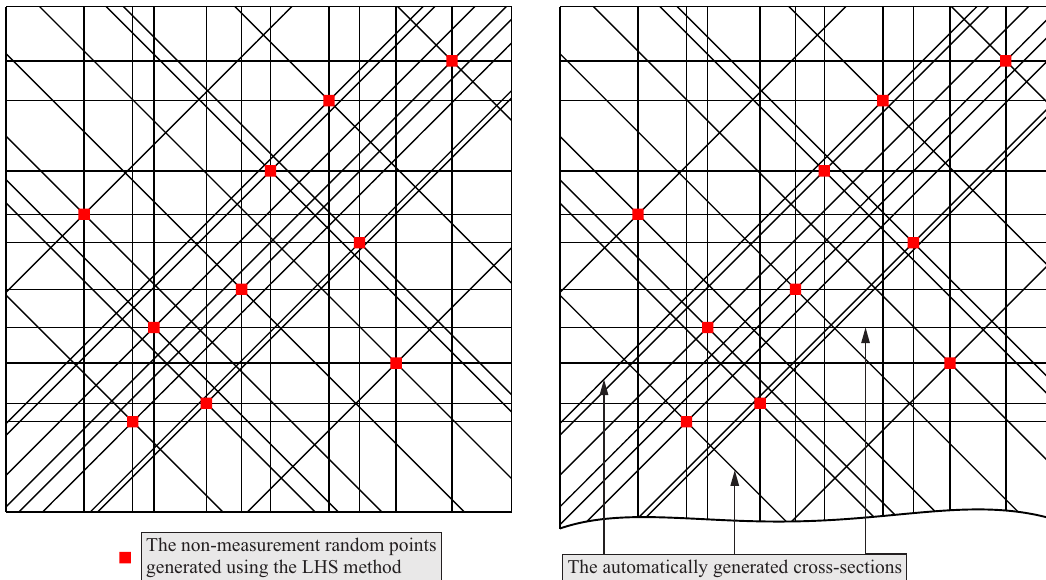
Figure 12. The generated cross-sections for two investigated free-form surfaces and the non-measurement points obtaind using the LHS